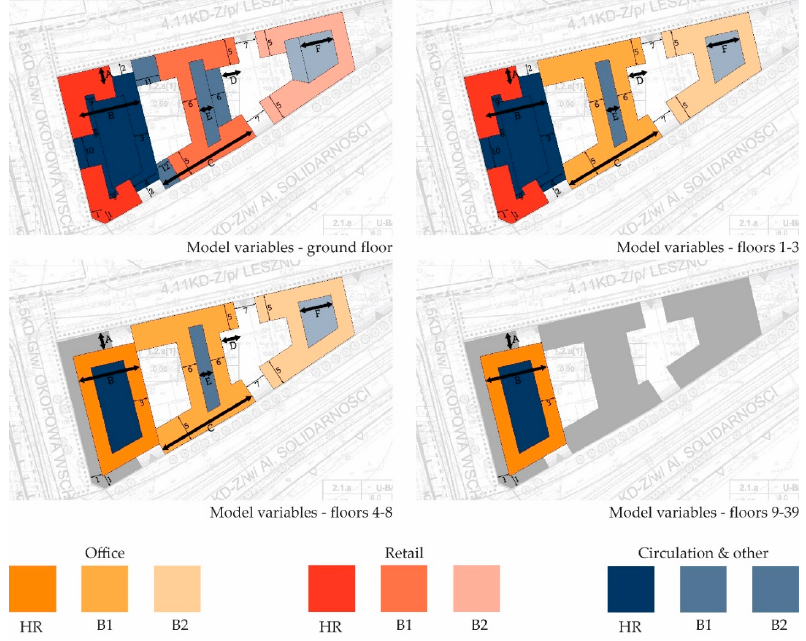
Figure 10. Variables used for the algorithmic model. Table 6. Variables used for the algorithmic model.